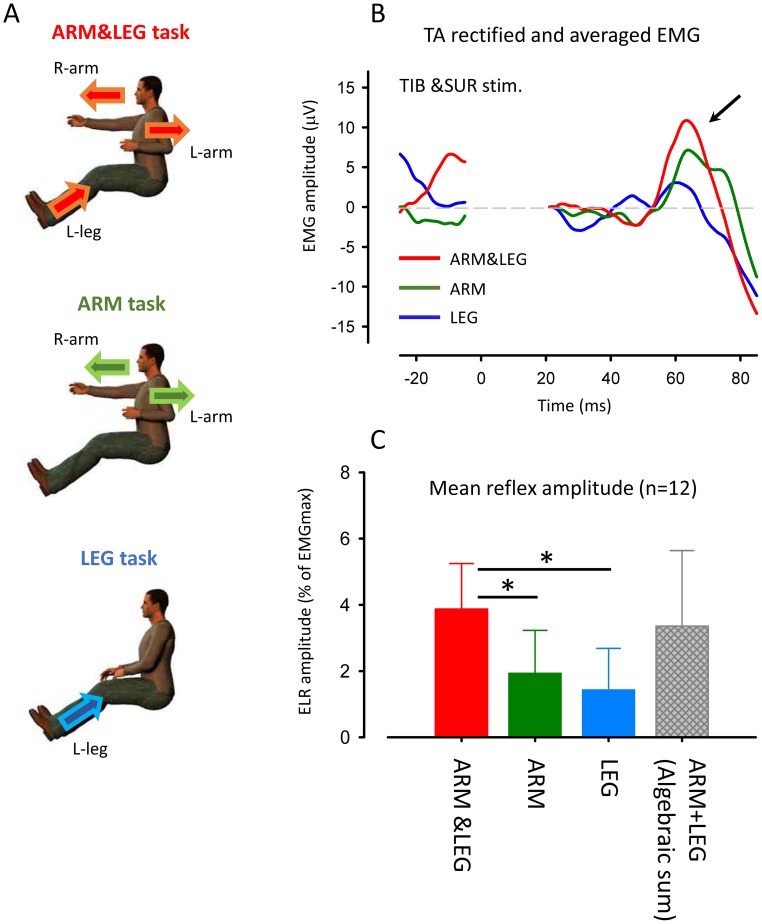
Effect of movement limbs on ELR following combined tibial and sural nerve stimulation (TIB&SUR).(A) Experimental tasks for remote rhythmic movements: arm and leg movement (upper panel, ARM&LEG), bilateral arm movement (middle panel, ARM) and contralateral leg movement (lower panel, LEG) (B) Full-wave rectified and averaged EMG in TA muscle following TIB&SUR stimulation during ARM&LEG (red trace), ARM (green trace) and LEG (blue trace) movement. (C) Grand means (± SD) of the magnitudes of early-latency reflex responses (45–80 ms after stimulation onset) following simultaneous combined stimulation of sural and tibial nerves during ARM&LEG (red bar), ARM (green bar) and LEG (blue bar) movement obtained from 12 subjects. Hatched gray bar: mathematical summation of reflex amplitude in individual tasks (ARM+LEG). * p<0.001.